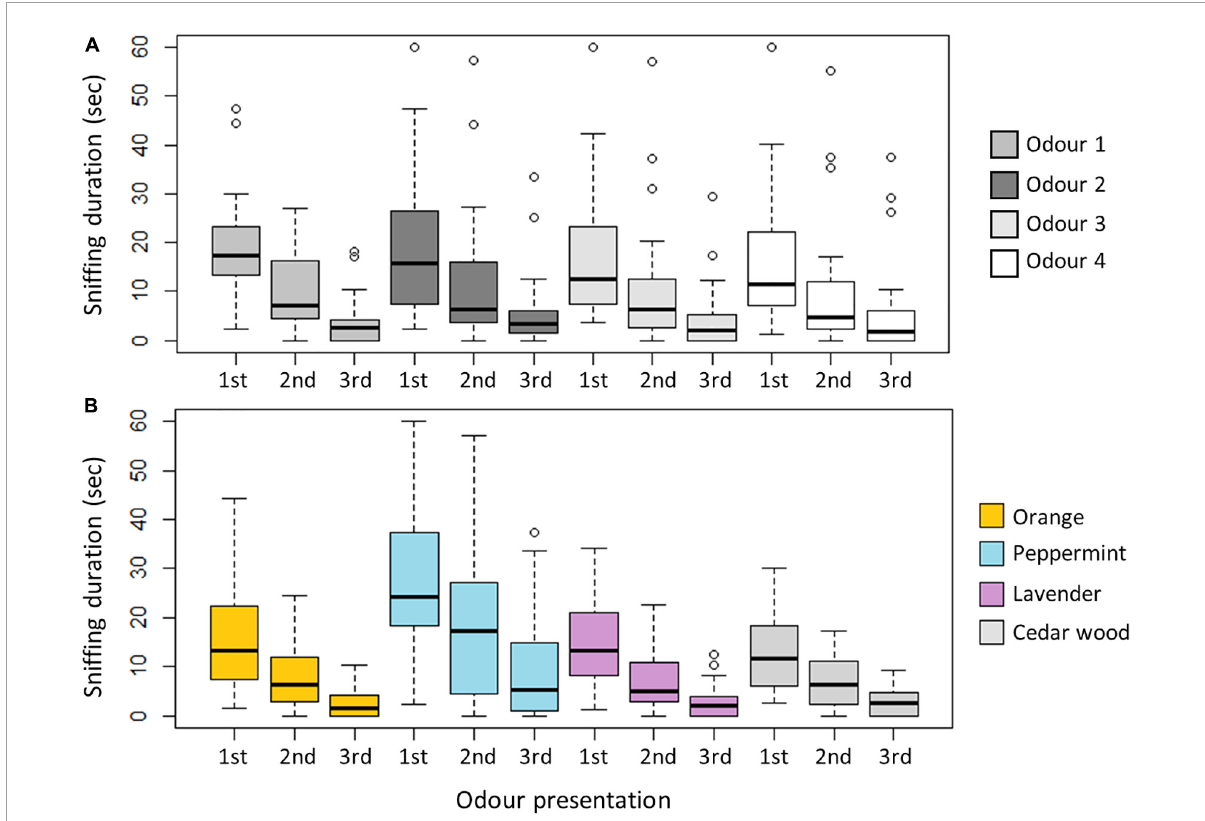
FIGURE2 (A) Illustration of sniffing duration per horse during odor presentations (1st, 2nd, 3rd) over time regardless of specific odor. (B) Illustration of sniffing duration per horse during odor presentations (1st, 2nd, and 3rd) for all odors, orange representing orange, light blue representing peppermint, purple representing lavender and light gray representing cedar wood. For both (A,B) the boxes represent the 25, and 75% quartiles, the thick line inside the box represent the median and the dashed lines illustrate the range.